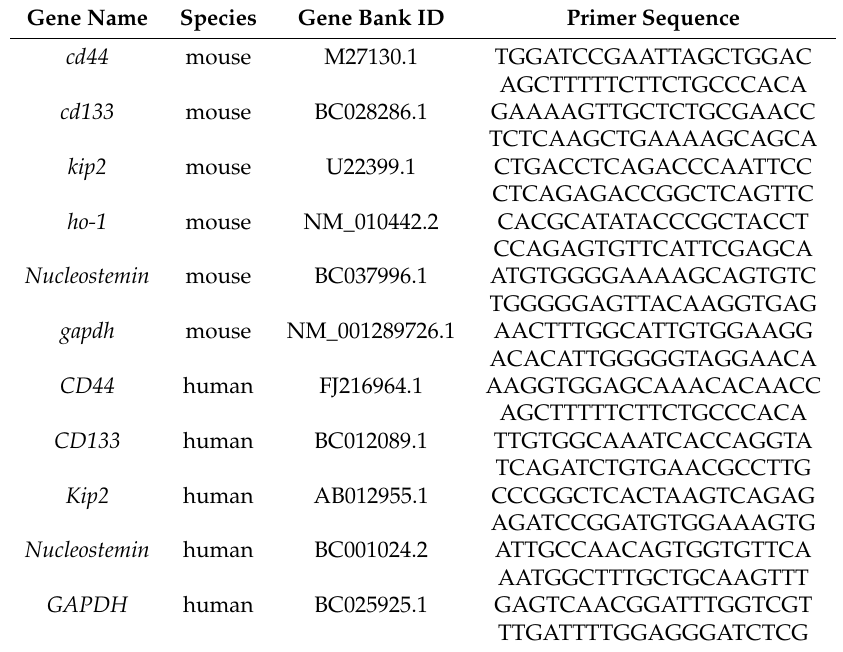
Table 1. Primer sets for